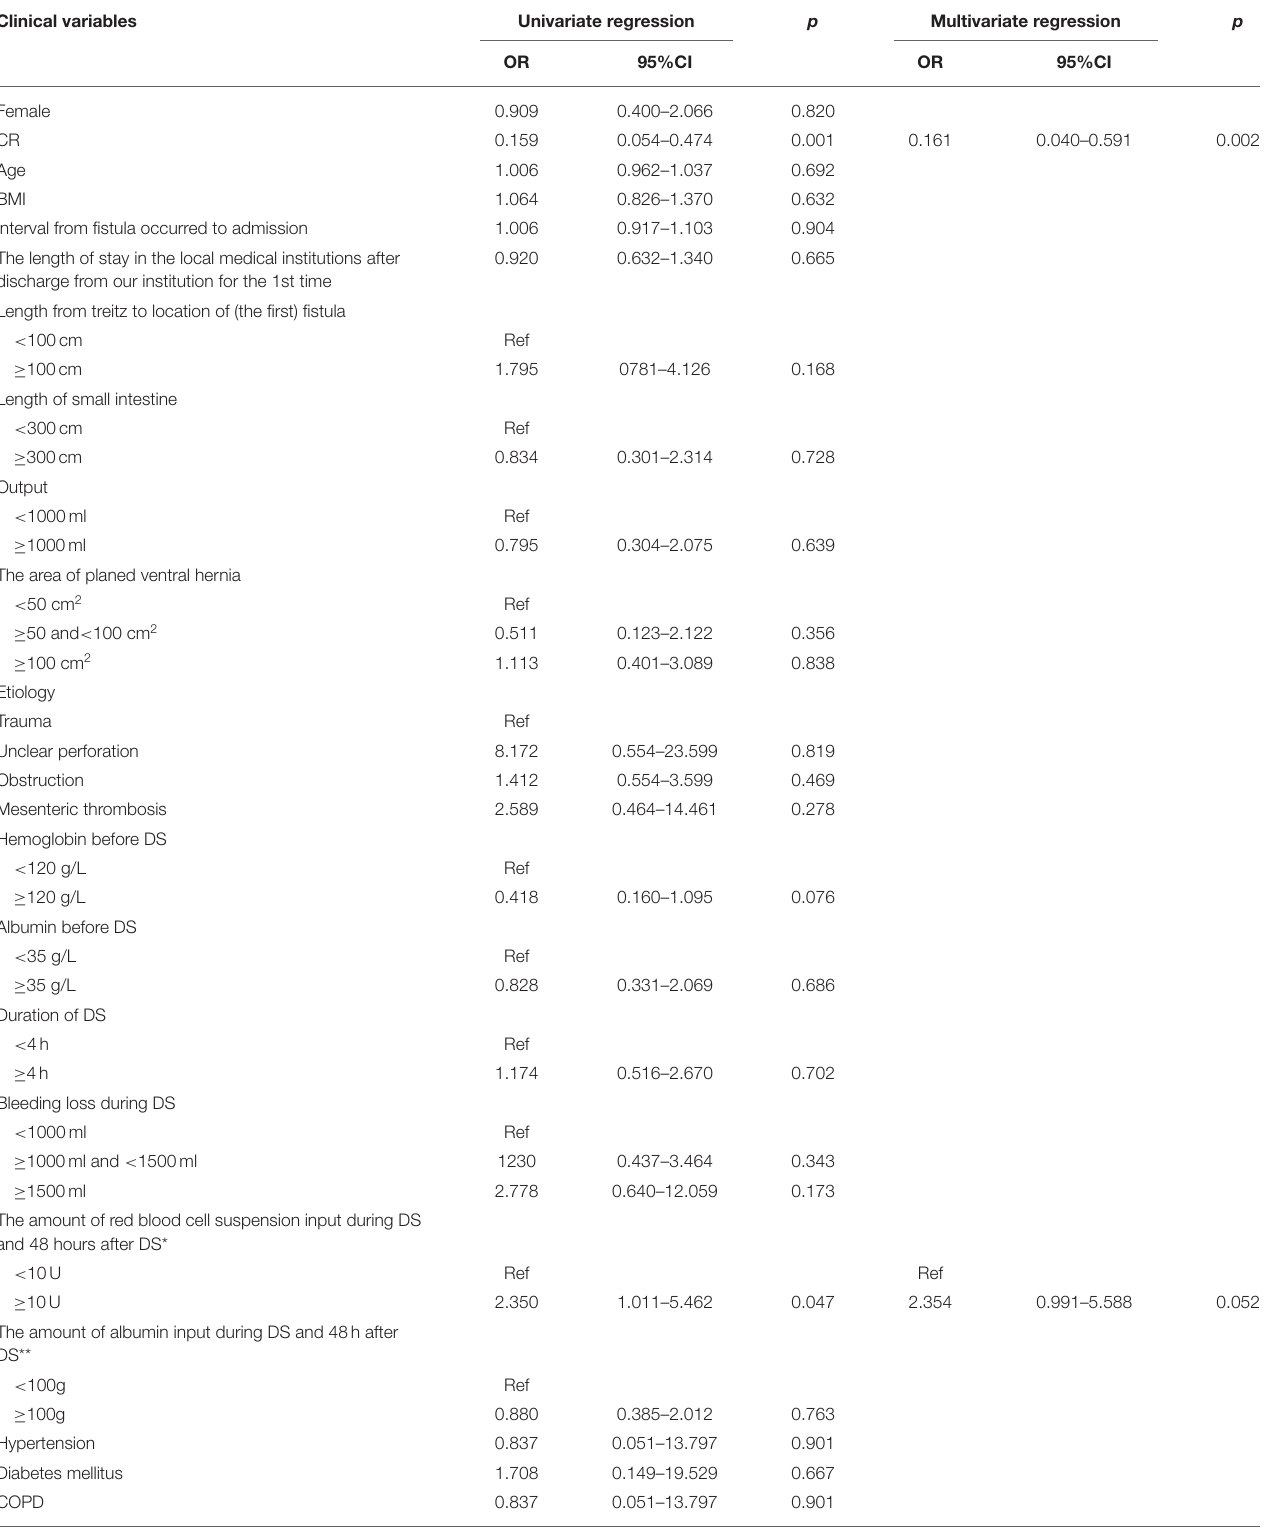
TABLE 6 | Logistic regression analysis of the risk factors for postoperative complications after